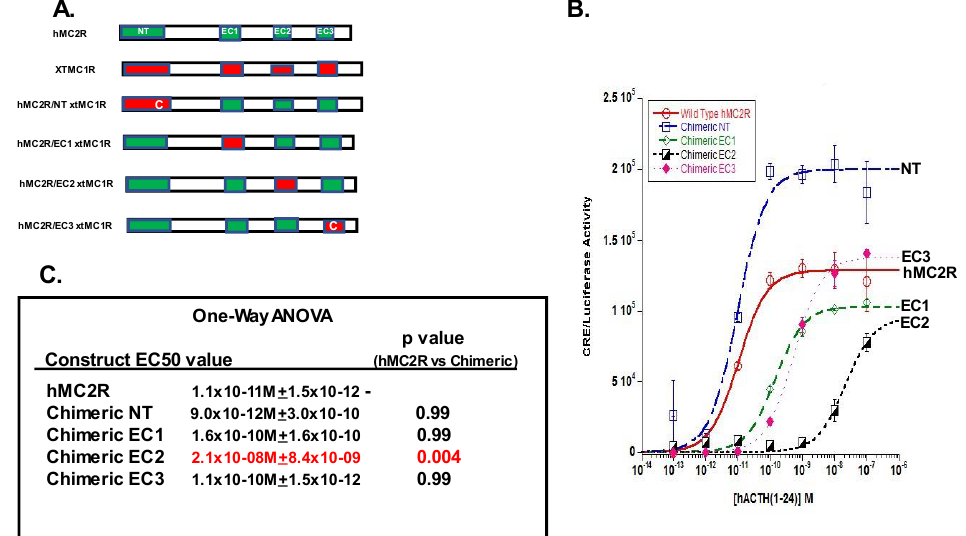
Figure 2. cAMP Reporter Gene Assay: Analysis of hMC2R/xtMC1R Chimeric Receptors. ( A ) The diagram shows the relative location of the extracellular domains present in hMC2R ( green ) and the corresponding domains present in xtMC1R ( red ), and the organization of the chimeric receptors. Note the insertion of a cysteine residue in hMC2R/NT xtMC1R and hMC2R/EC3 xtMC1R. Abbreviations: C (cysteine), NT (N-terminal domain), EC1 (extracellular domain 1), EC2 (extracellular domain 2), EC3 (extracellular domain 3). ( B ) Dose response curves for wild-type hMC2R, hMC2R/NT xtMC1R (Chimeric NT), hMC2R/EC1 xtMC1R (Chimeric EC1), hMC2R/EC2 xtMC1R (Chimeric EC2), and hMC2R/EC3 xtMC1R (Chimeric EC3) all co-expressed with mMRAP1 in CHO cells as described in Methods, and stimulated with hACTH(1-24). ( C ) The EC 50 value for each dose response curve is presented ( n = 3) and the results of One-way ANOVA analysis of the EC 50 values. A p value < 0.05 is highlighted in red.